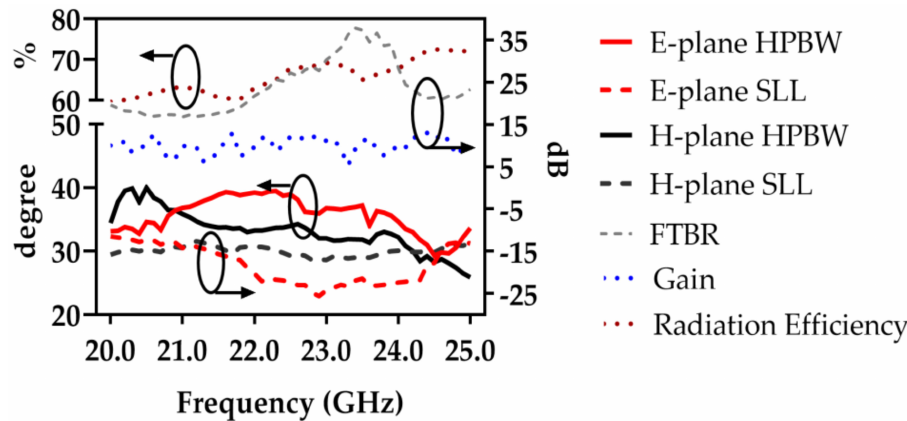
Figure 8. Measured and simulated pattern at 22.7 GHz; ( a ) E-plane; ( b ) H-plane.